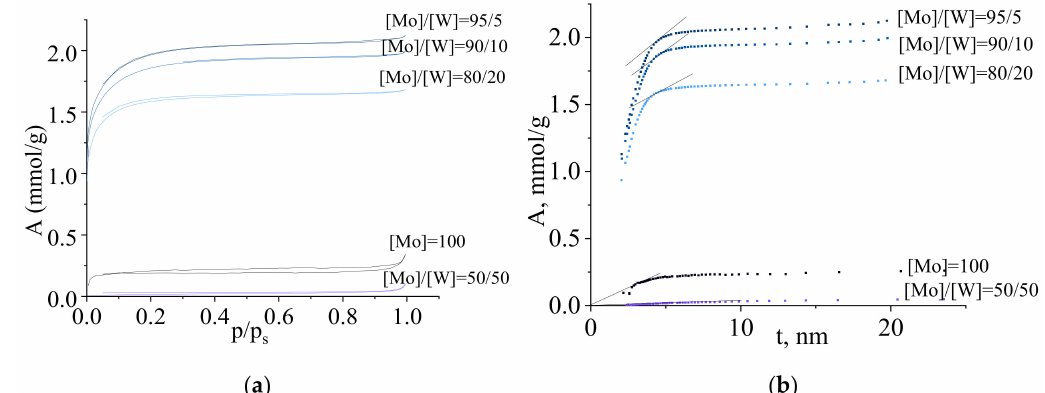
Figure 7. ( a ) Nitrogen adsorption / desorption isotherms and ( b ) t-plots on molybdenum-tungsten carbides synthesized from molybdenum-tungsten blue xerogels (calcined at 900 ◦ C in inert atmosphere) with di ff erent ratios [Mo] / [W].